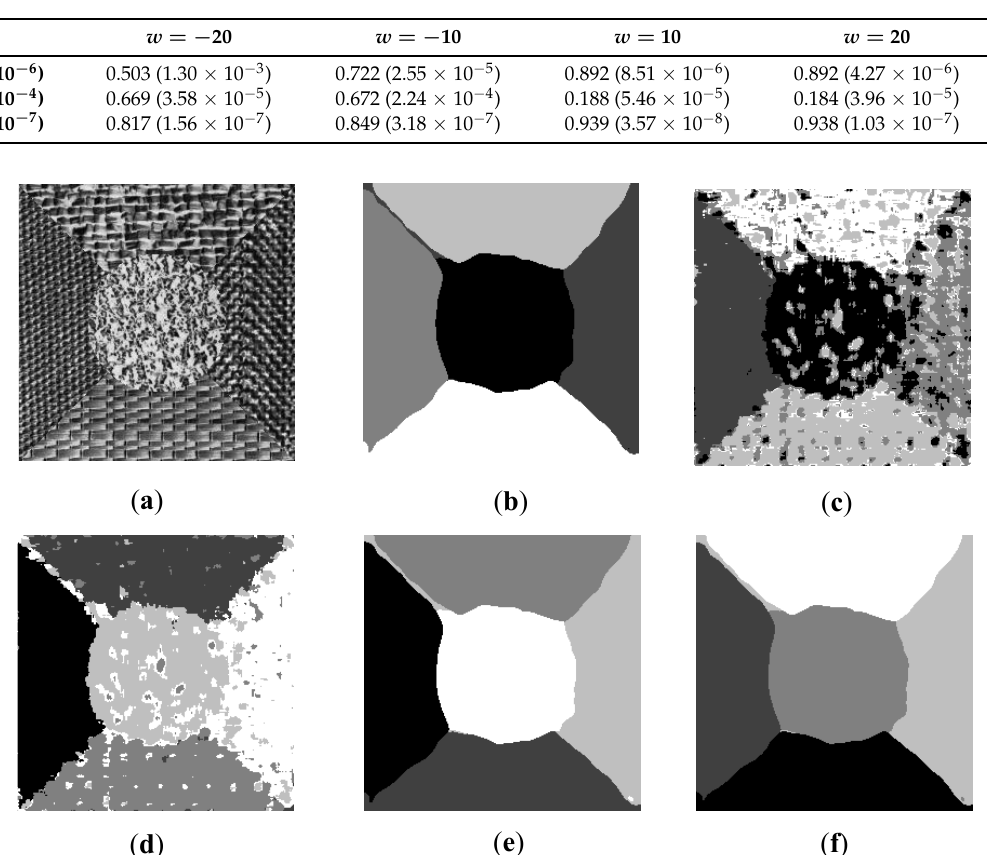
Table 4. Mean and variance of ARI for five different feature weights.